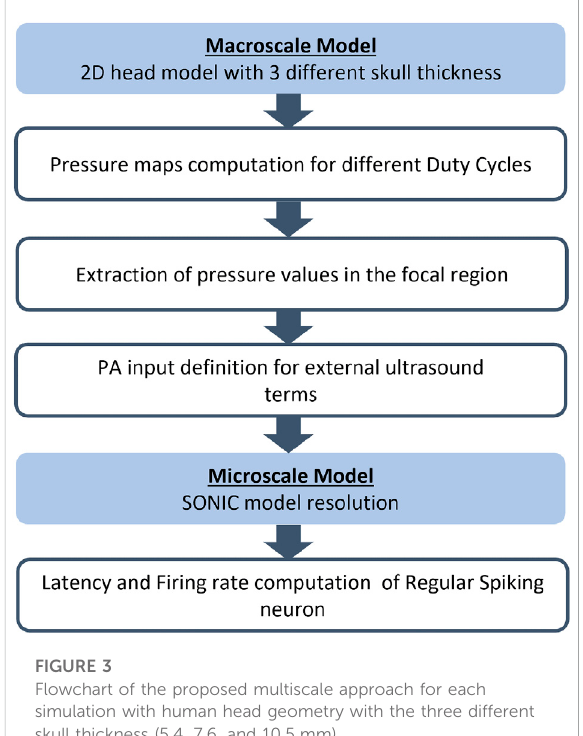
FIGURE 3 Flowchart of the proposed multiscale approach for each simulation with human head geometry with the three different skull thickness (5.4, 7.6, and 10.5